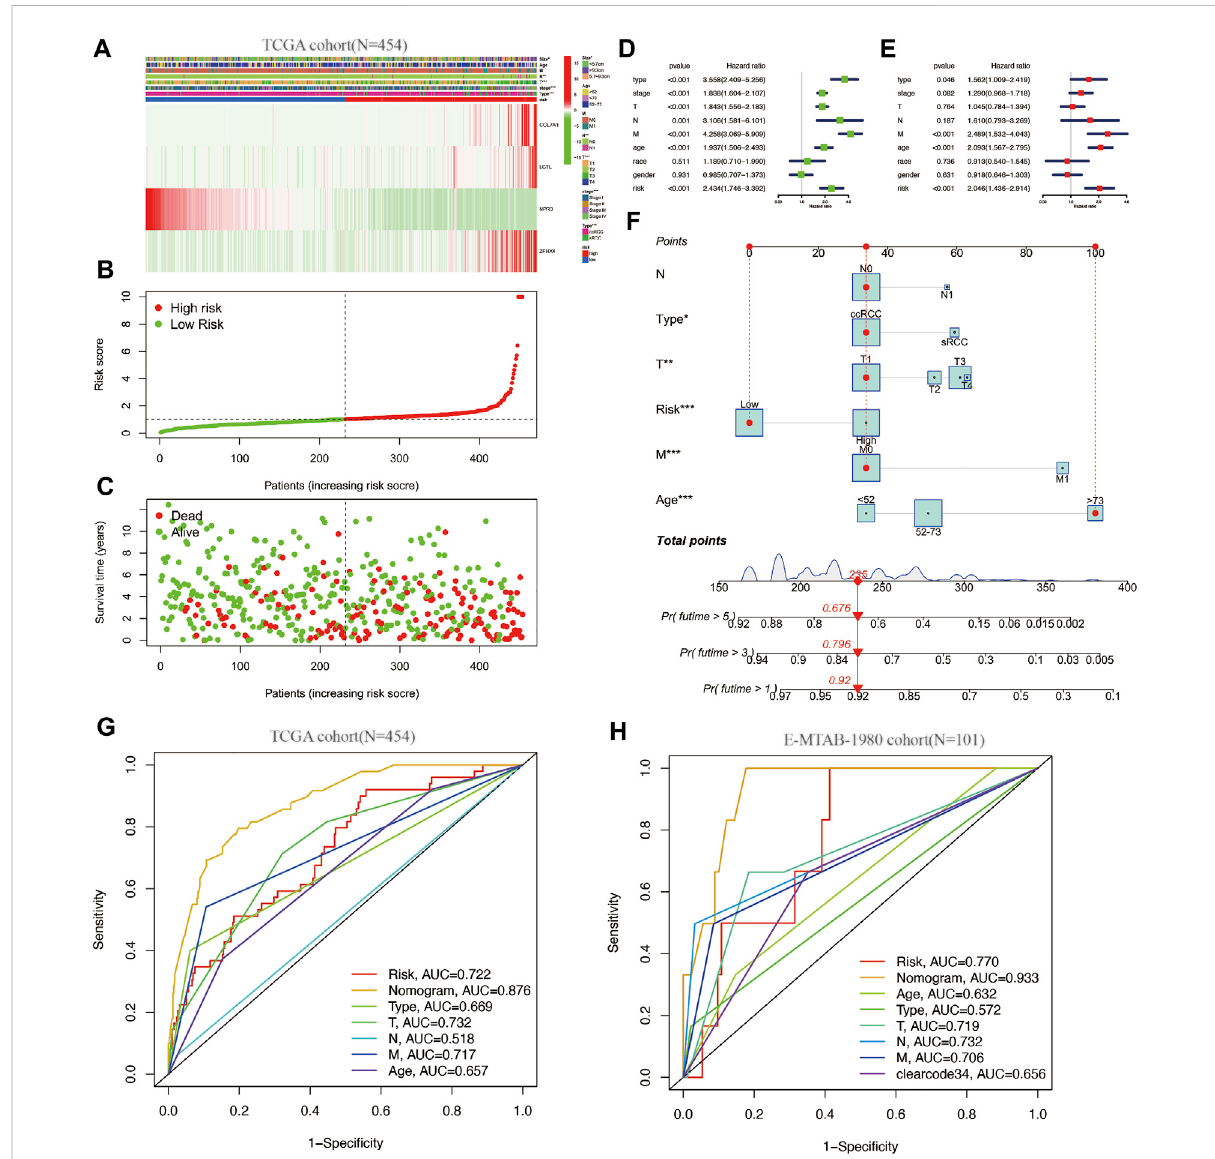
FIGURE 3 (A – C) :clinicalinformationandgeneexpressionheatmapoftheSAGRIsubgroup; (D) :one-factorCOX regression